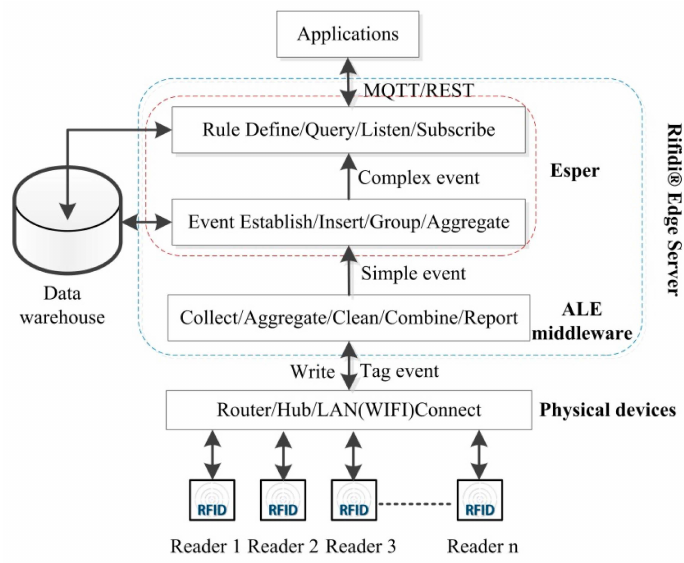
Figure 3. RFID complex event processing